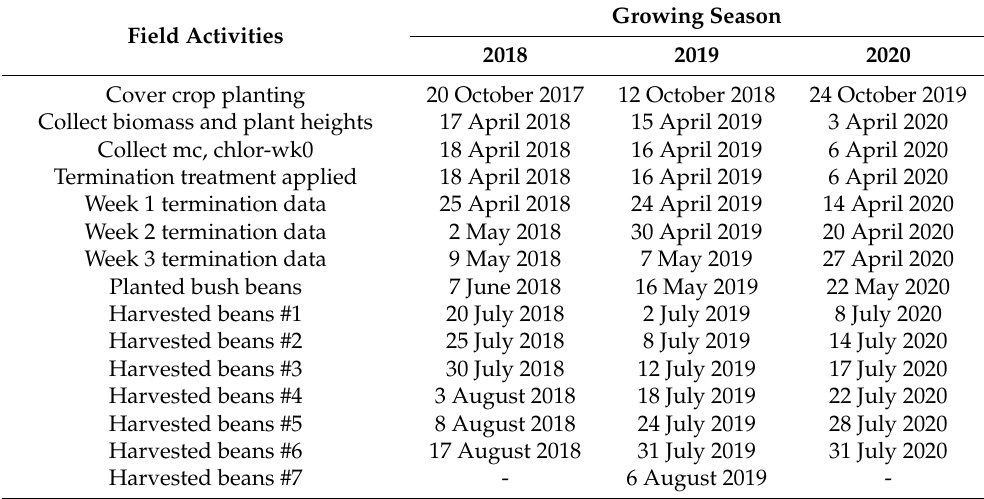
Table 1. Detailed field activities of the experiment during three growing seasons